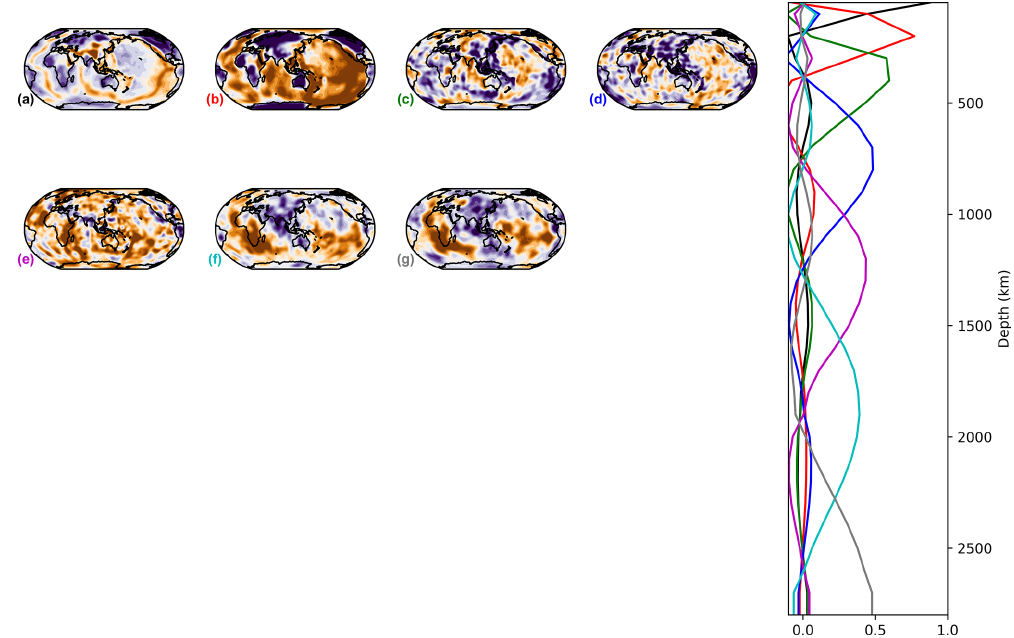
Figure C2. The seven varimax components of the isotropic part of the SAVANI model.